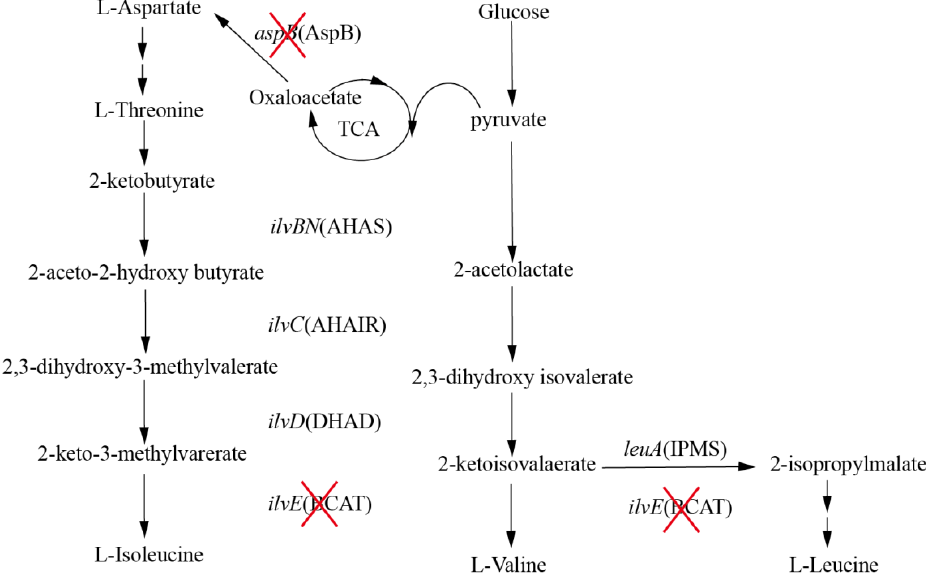
Figure 1. Biosynthesis of BCAAs. The genes and enzymes are shown in italic font and in parentheses. AHAS ( ilvBN ) acetohydroxyacid synthase, AHAIR ( ilvC ) acetohydroxyacid isomeroreductase, DHAD ( ilvD ) dihydroxyacid dehydratase, BCAT ( ilvE ) branched-chain amino acid aminotransferase, IPMS ( leuA ) 2-isopropylmalate synthase, AspB ( aspB ) aspartate aminotransferase. Deletion of genes and the respective proteins are indicated by “X”.